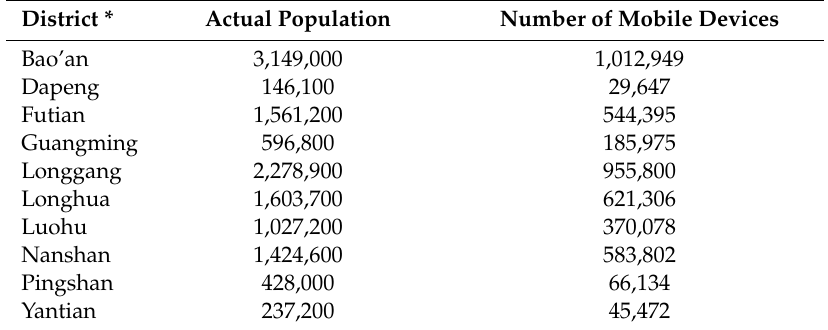
Table 1. Actual population statistics and the volume of active mobile devices in di ff erent districts. District * Actual Population Number of Mobile Devices Bao’an 3,149,000